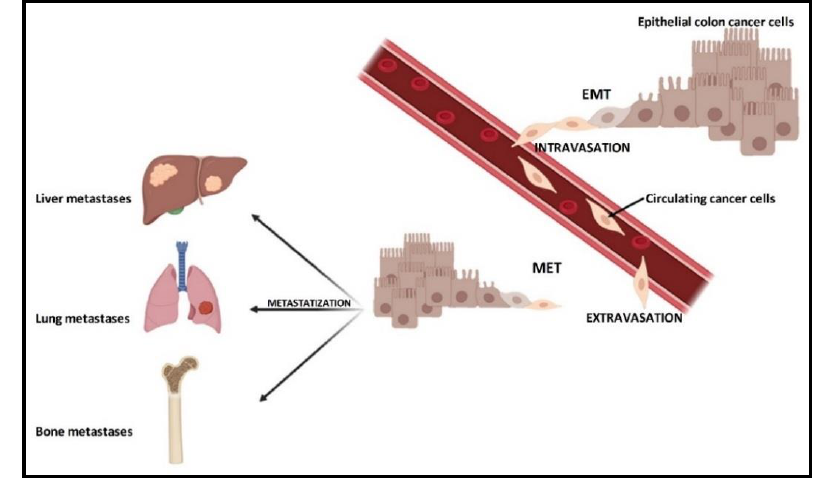
Figure 1. Colorectal cancer and its metastatic tropism. Primary tumor cells can be subjected to epithelial–mesenchymal transition (EMT), in order to generate mesenchymal cells with more motility and invasiveness. These mesenchymal cells enter the bloodstream, becoming circulating cancer cells (intravasation). Through the blood flow and under cellular signals, these cells reach distant sites where they metastasize. At this point, the circulating cancer cells come out from the blood stream